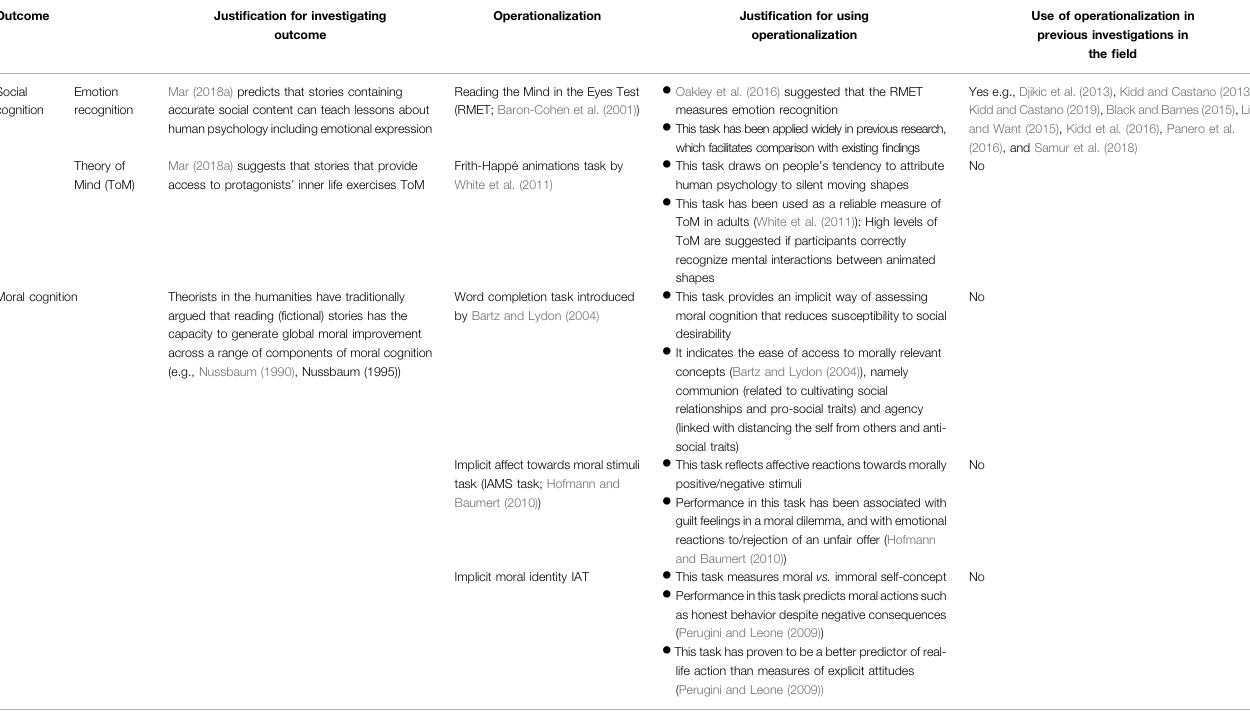
TABLE 1 | Overview and justi fi cation of dependent variables, their operationalization, and their use in previous experiments on narrative-based bene fi ts for social and moral cognition.